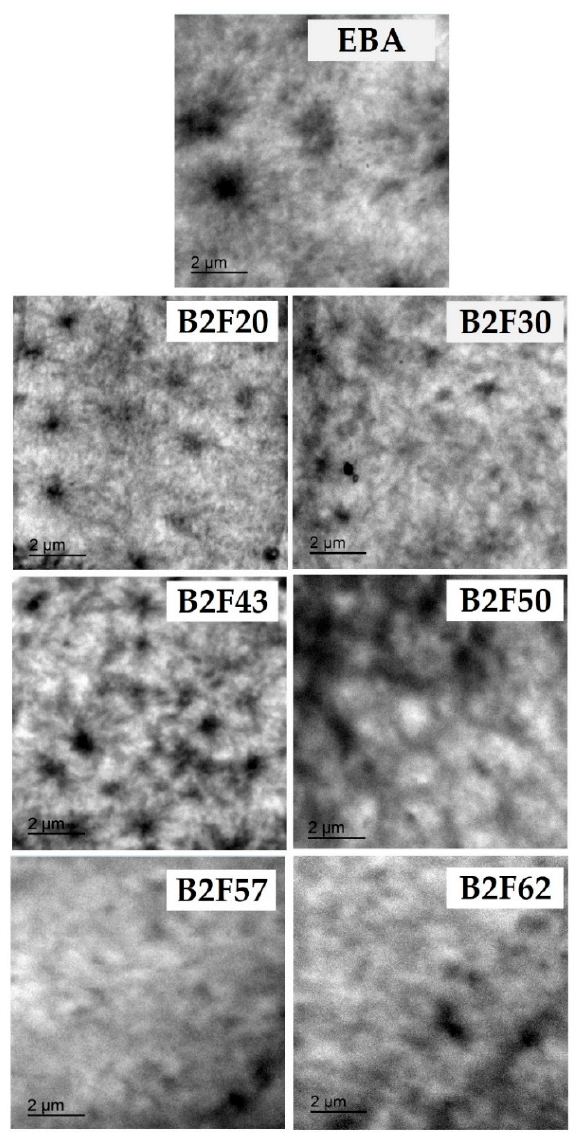
Figure 8. TEM micrographs of the EBA copolymer and EBA copolymer + ECH resin blends.